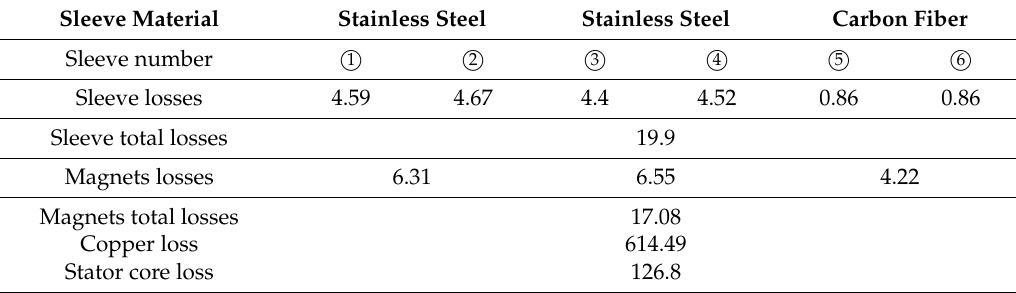
Table 7. Losses in different parts of PMSM under Design 2 (W).